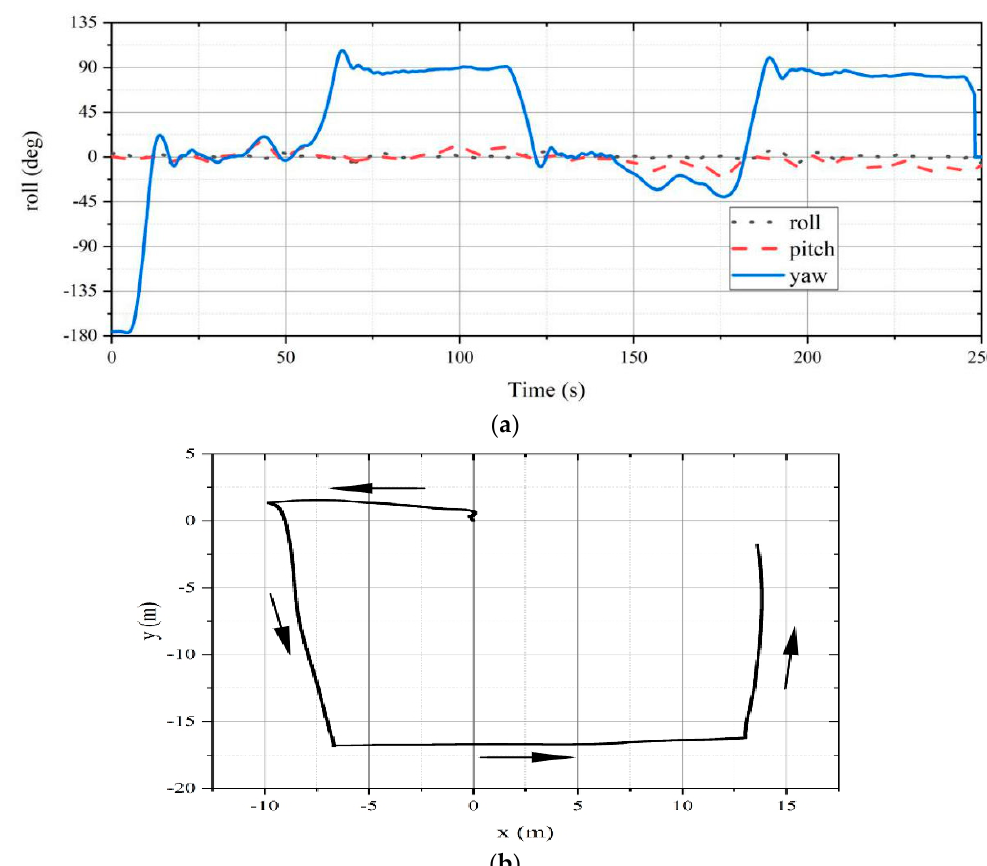
Figure 15. The quadrangle motion experiment in the horizontal plane. ( a ) The pitch, roll and yaw angle of AUH during the quadrangle motion experiment; ( b ) estimation of the trajectory of AUH.